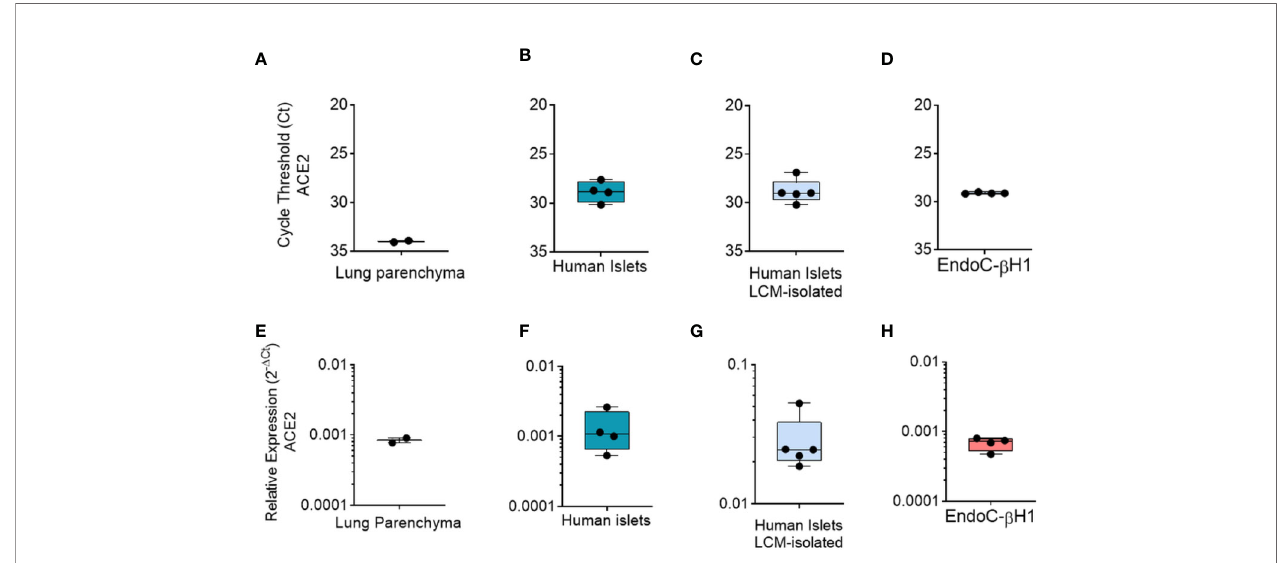
FIGURE 6 | qRT-Real Time PCR analysis of ACE2 mRNA. (A – D) ACE2 raw Ct values results in lung tissue (n = 1, in duplicate), in enzymatic-isolated human pancreatic islets samples (n = 4), in LCM-microdissected islets (n = 5) and in EndoC- b H1 (n = 4). (E – H) ACE2 expression values normalized using GAPDH and b 2- microglobulin of the samples analysed in A – D. Values are reported as 2 − dCt . Mean ± S.D. values are